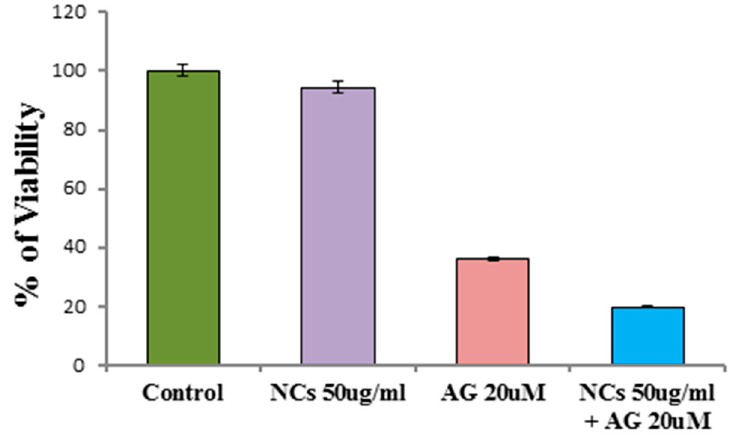
Figure 10. Neutral red cytotoxicity assay of the control, Fe 3 O 4 /HAp NCs, drug (AG), and AG-loaded Fe 3 O 4 /HAp NCs.